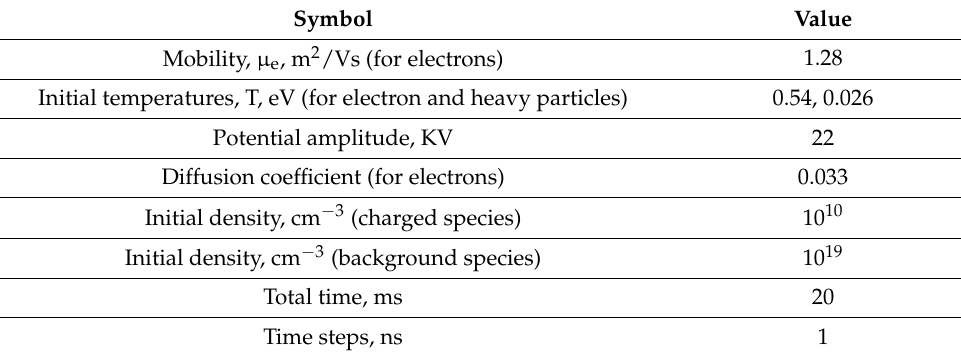
Table 6. The simulation parameters. Symbol Value Mobility, µ e , m 2 /Vs (for electrons) 1.28